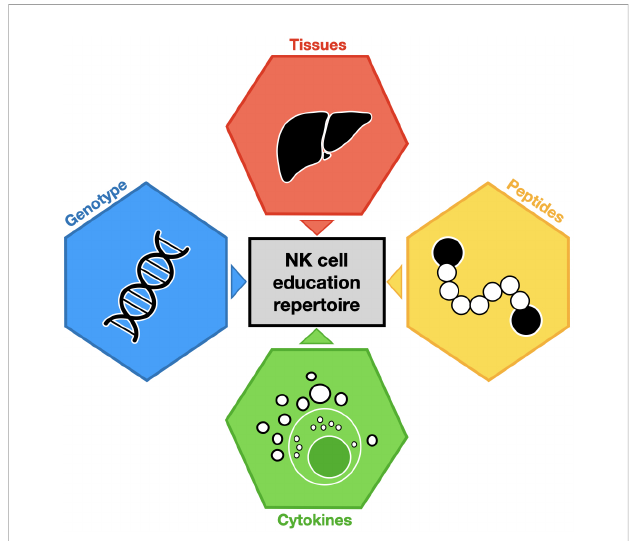
FIGURE 1 Major environment contributions to NK cell education repertoire. Each colored hexagon indicates a factor involved in NK cell education. The impact of these factors on NK cell education is symbolized by colored